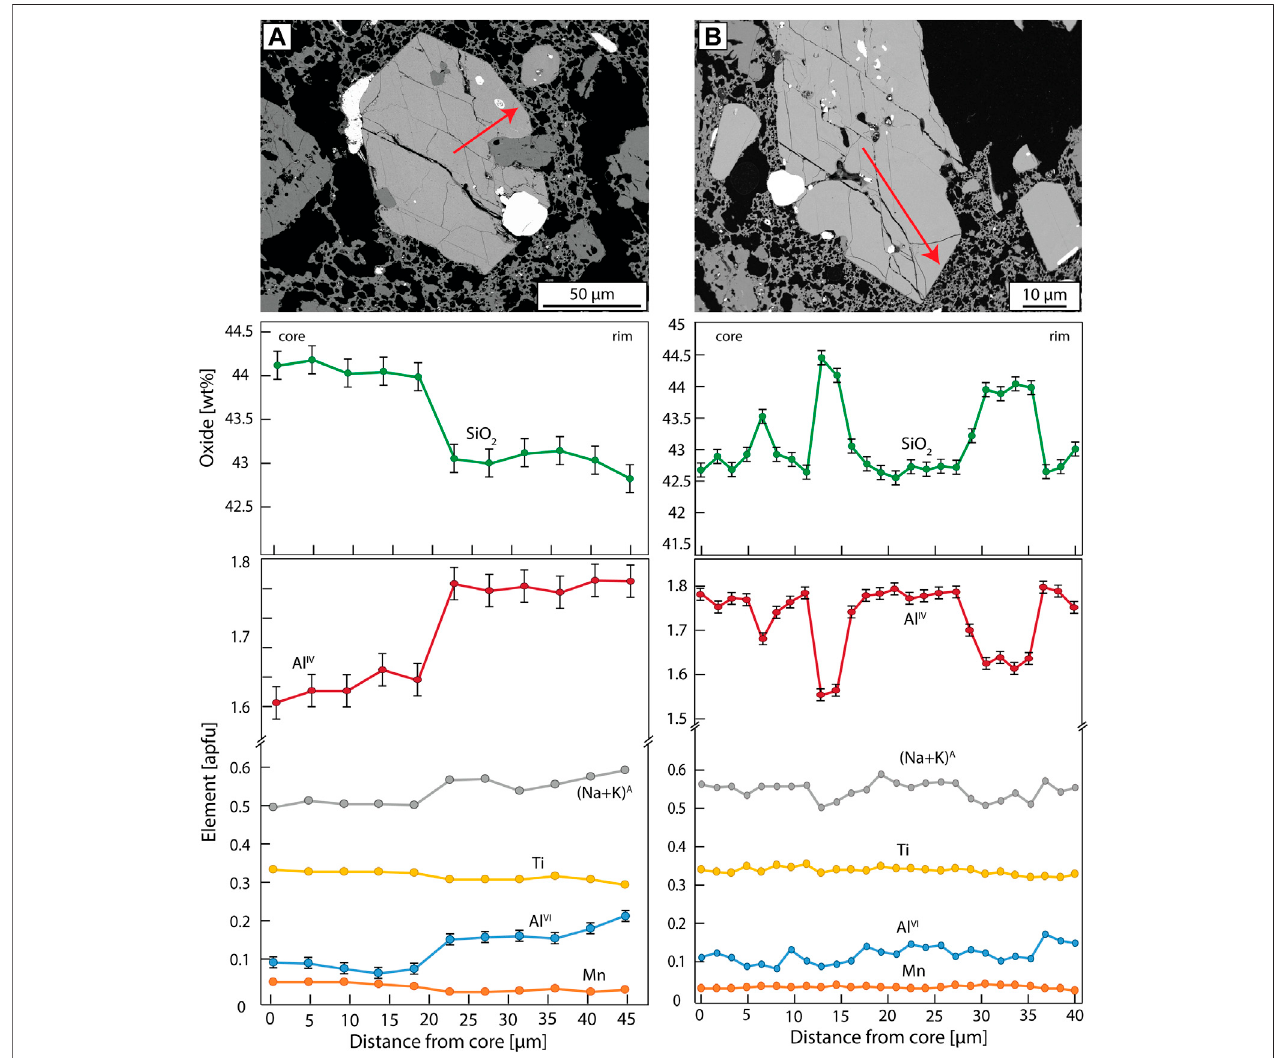
FIGURE 7 | Core-to-rim concentration pro fi les of Aso-4 amphibole. Pro fi le trajectories are indicated by red arrows in back-scattered images. (A) shows the most common zoning pattern of Aso-4 amphibole (present in about one third of the measured amphiboles) displaying increasing Al IV , (Na + K) A and Al VI concomitant with decreasingSiO 2 ,TiandMntowardtherimindicatingincreasingreservoirtemperatureduringcrystallization.Changesmightalsobein fl uencedbychangingpressureand melt composition. (B) shows an oscillatory zoned amphibole with recurring Al IV , (Na + K) A and Al VI troughs suggesting cyclic reheating/recharging of the reservoir during amphibole fractionation. Where not given errors are smaller than the